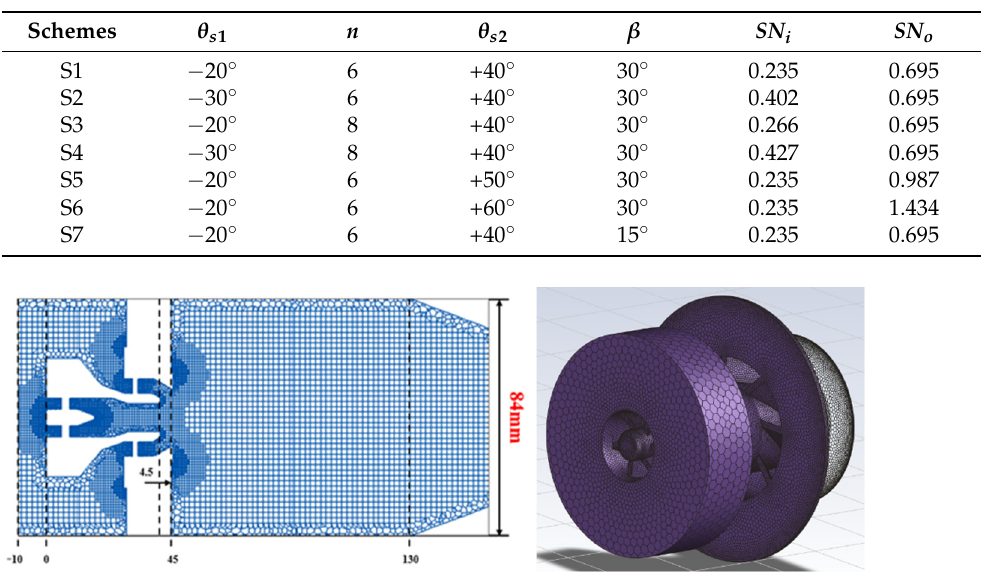
Figure 2. The grids of the combustor with two-stage swirler. (The length of the computational domain is 310 mm, the axial coordinate of the swirler inlet is selected to be 0 mm, the axial coordinate of swirler exit is 45 mm.).